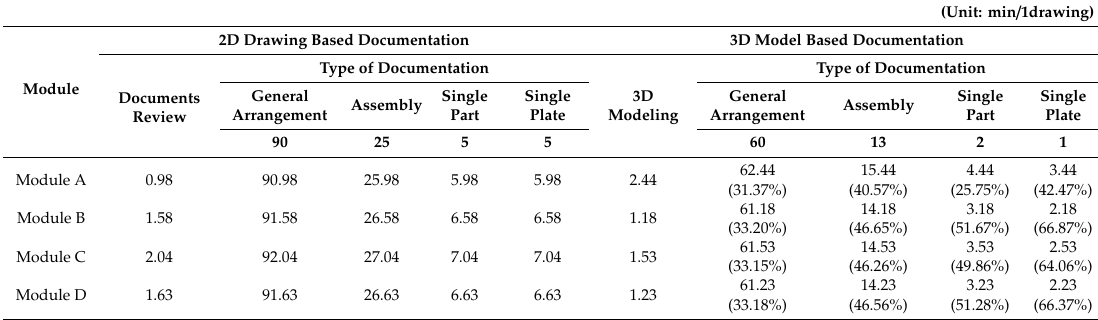
Table 6. Comparison analysis of 2D-drawing-based documentation (including working time of documents review) and 3D-model-based documentation (including working time of 3D modeling)